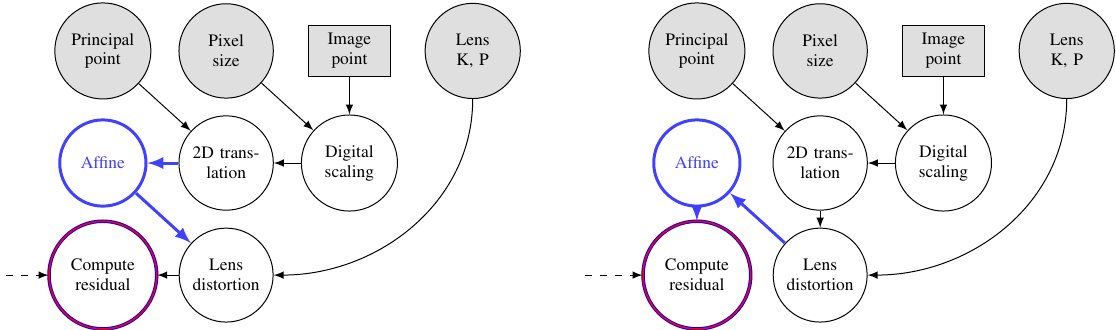
Figure 4: Two versions of the right-hand side of Figure 2 with different relative placement of the affine transformation with respect to lens distortion. In Model 3 (left), the affine distortion was applied before lens distortion. In Model 4 (right), the affine distortion was applied after lens distortion. Note that in both cases, the digital scaling uses square pixel sizes. Any non-unit aspect ratio is handled by the affine step.